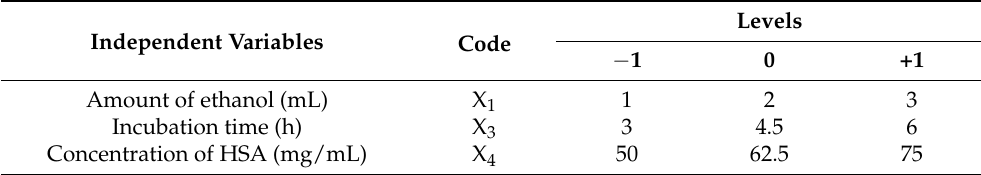
Table 2. Independent variables selected for further optimization after the screening study, their codes, and the investigated values in the 3-level, 15-run Box–Behnken factorial design. Levels Independent Variables Code − 1 0 +1 Amount of ethanol (mL) X 1 1 2 3 Incubation time (h) X 3 3 4.5 6 Concentration of HSA (mg/mL) X 4 50 62.5